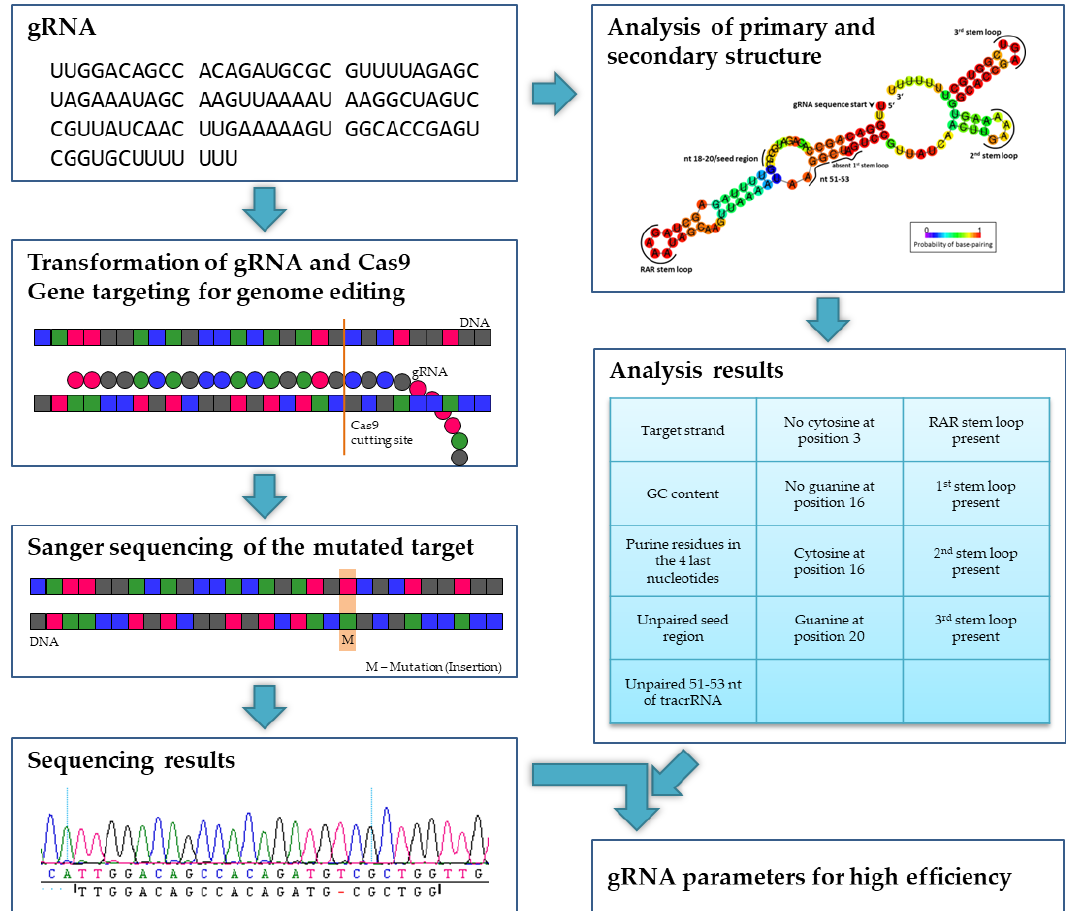
Figure 2. Experimental design. In poplars, a gRNA and the Cas9 nuclease were transformed. After regeneration, the target regions were sequenced and screened for mutations (in this example, an insertion). Together with the analysis of the primary and secondary structure of the gRNA, parameters for a high editing efficiency were determined.